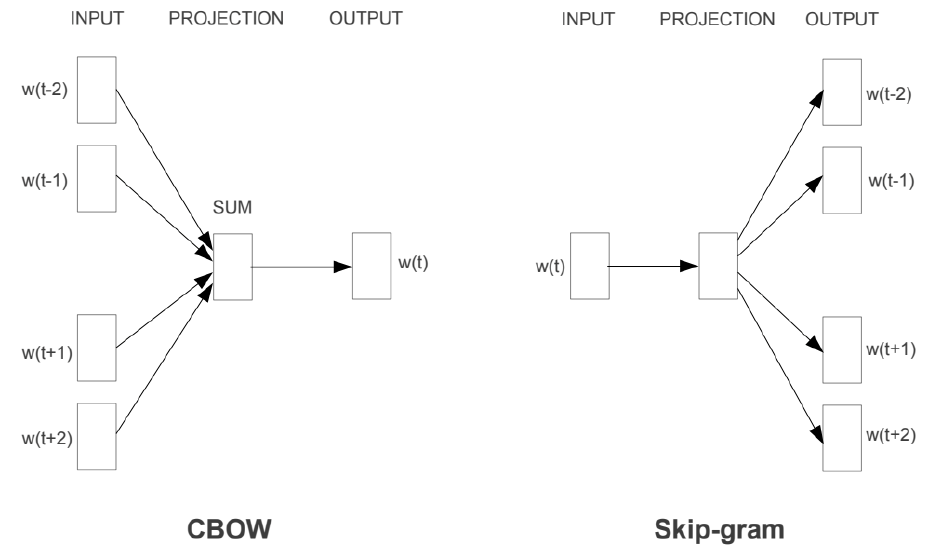
Figure 1. Word2Vec model architecture